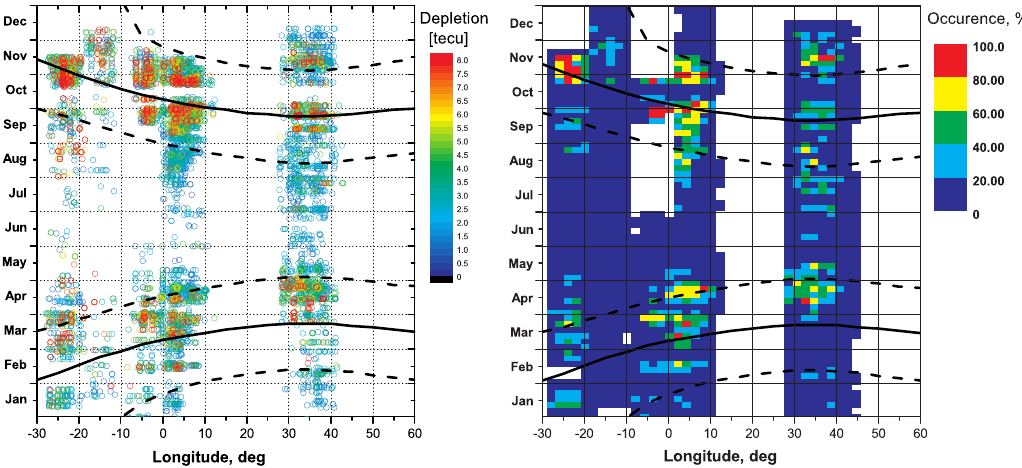
Fig. 5. Left panel: EPB intensity (TEC depletion depth in TECU) as a function of day of the year and longitude. Right panel: EPB occurrence rate. On the left panel all detected EPBs are shown, while on the right panel, data are binned in 5 degrees × 5 day blocks, for which the occurrence rate is calculated. Black solid lines indicate the region where the solar terminator is best aligned with the local geomagnetic field. Black dashed lines indicate regions where this angle is equal to 15 degrees. The climatology of the EPBs overall is in agreement with that of the GPS scintillations shown in Fig.